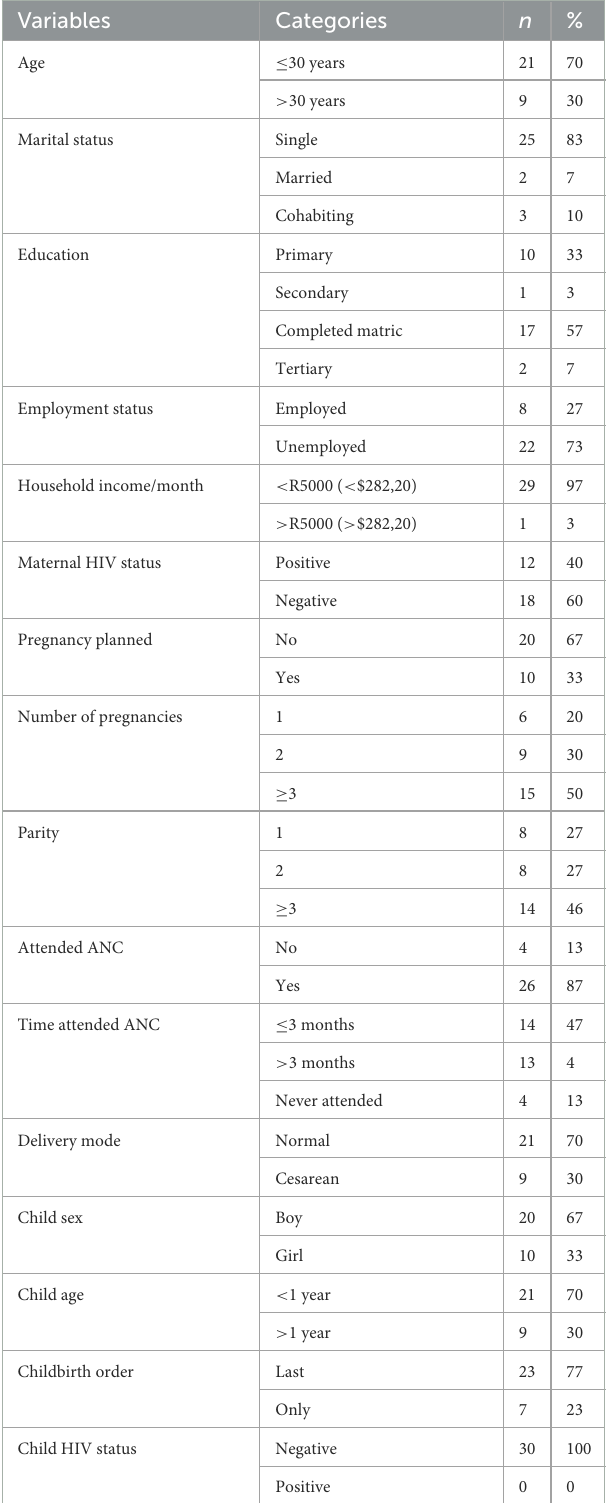
TABLE 1 Characteristics of the mothers and